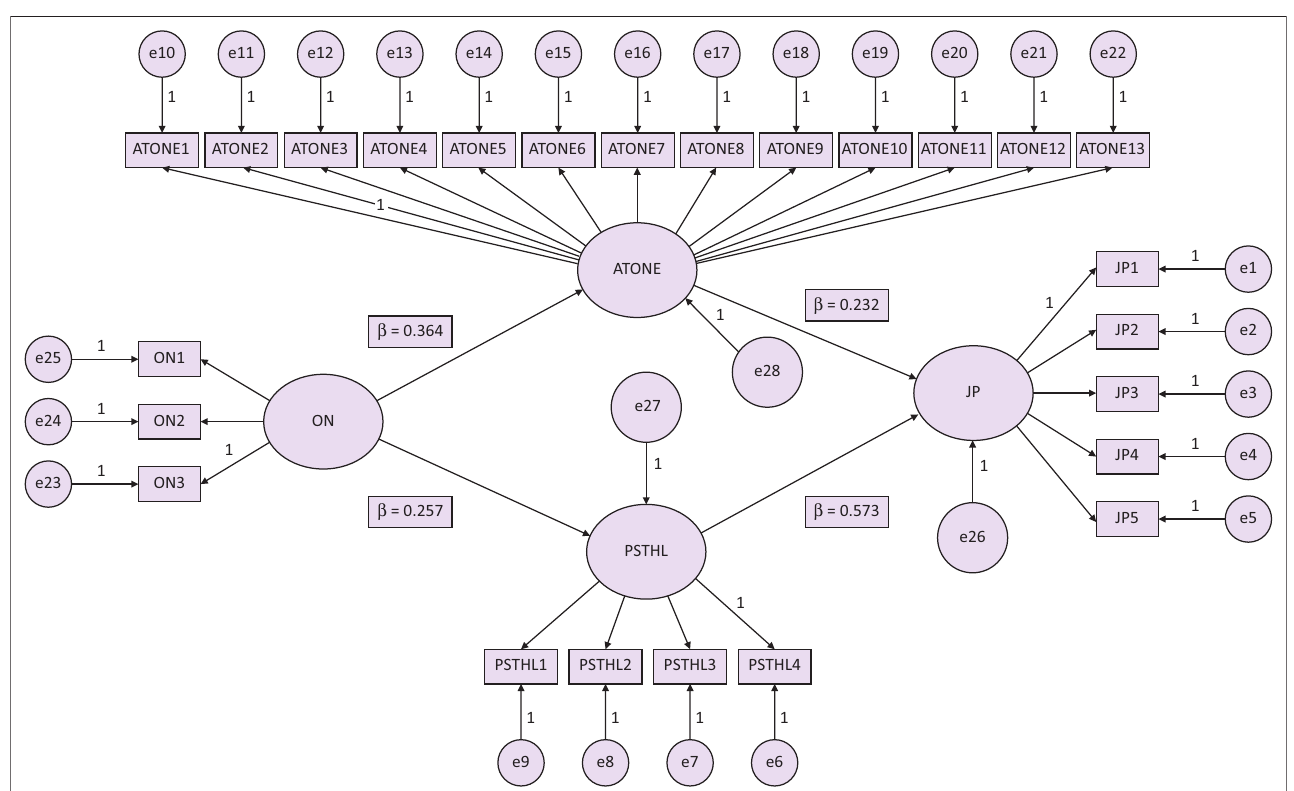
FIGURE 2: The final structural model of the